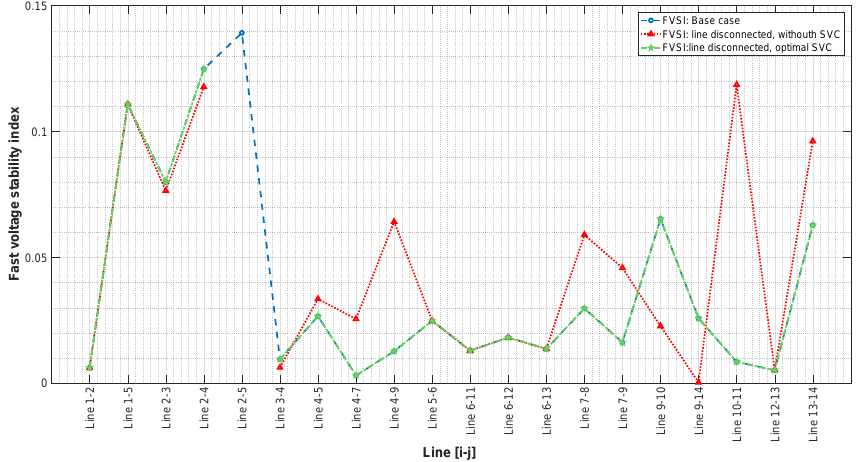
Figure 7. First study case: FVSIs before/after contingencies and with SVC compensation, when the weakest line is